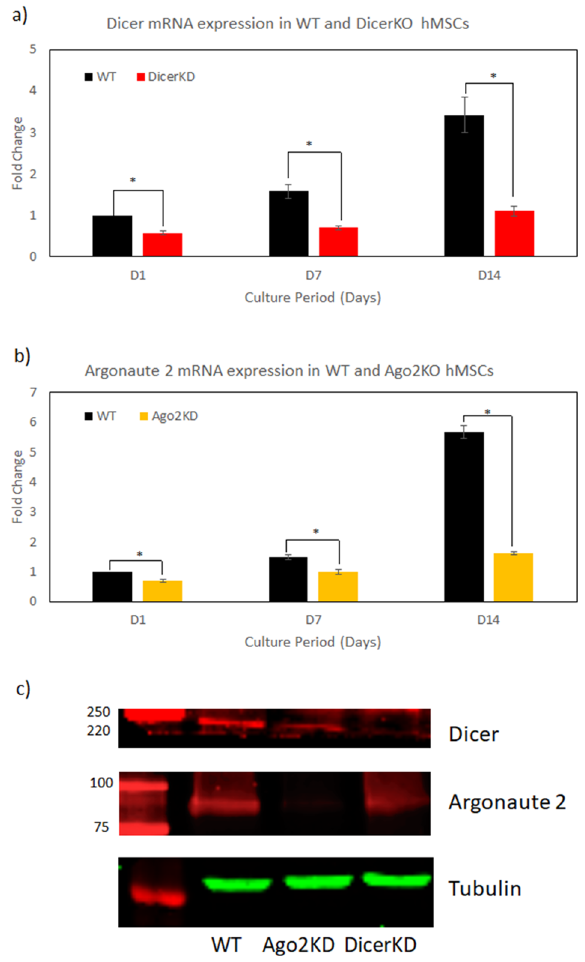
Figure 1. Characterization of Dicer and AGO2 knockdown. ( a ) Relative expression of Dicer mRNA was significantly downregulated (* P < 0.01) in DicerKD compared to WT hMSCs after 1, 7 and 14 days cultured in osteogenic medium. ( b ) Relative expression of Argonaute2 mRNA was significantly downregulated (* P < 0.01) in AGO2KD compared to WT hMSCs after 1, 7 and 14 days cultured in osteogenic medium. Fold changes are calculated relative to WT day 1 and Mann–Whitney U test was utilized for statistical analyses. ( c ) Immunoblotting showed successful knockdown of Dicer and Argonaute2 proteins in DicerKD and AGO2KD cells, respectively. Regions of interest of scans of one nitrocellulose blot probed with either anti-Dicer or anti- AGO2 or anti-tubulin primary antibody and corresponding secondary antibodies are